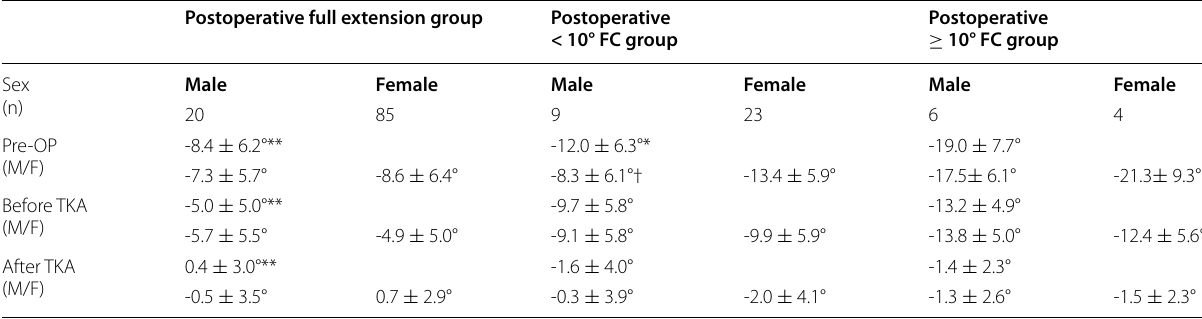
Table 4 Mean knee extension angle changes among three groups classified by a degree of postoperative knee extension angle at